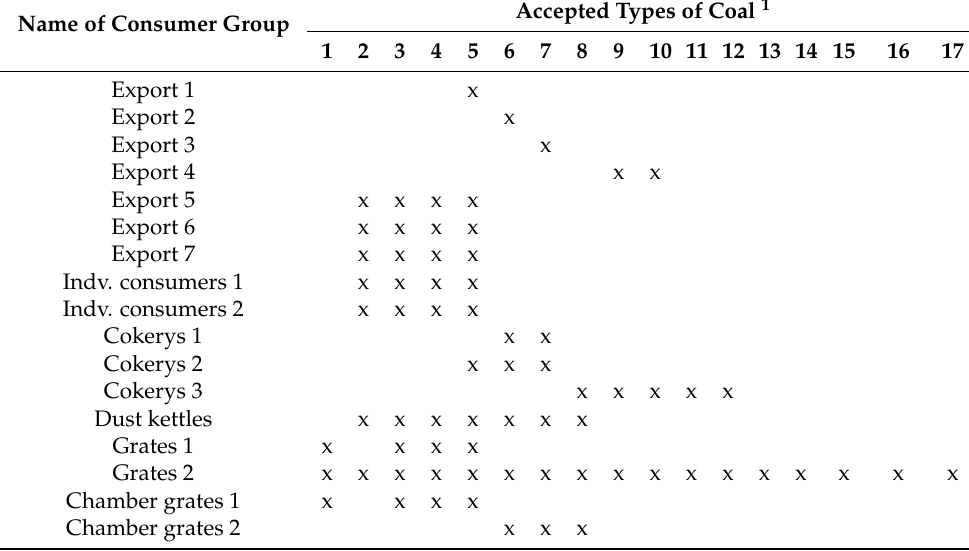
Table 3. The characteristics of the company’s aggregated consumer